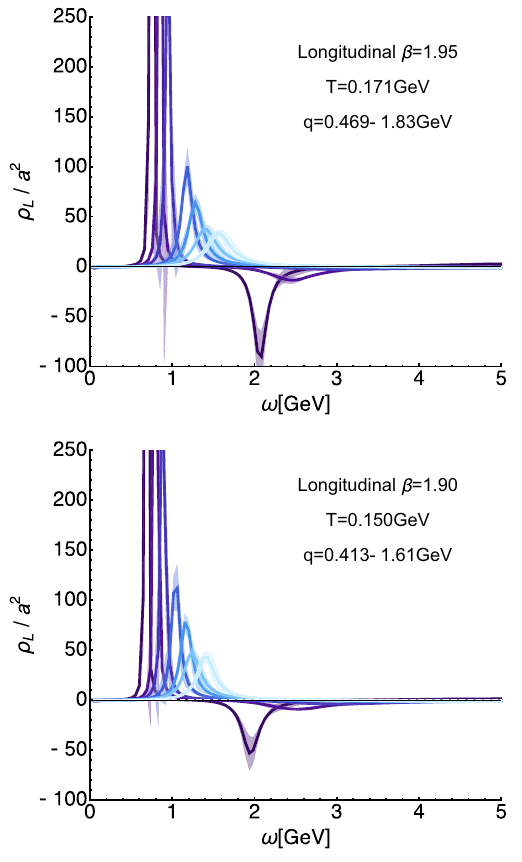
Fig. 8 For completeness we show here the reconstructed longitudinal (left) and transversal (right) gluon spectra on the β = 1 . 95 (top) and β = 1 . 90 (bottom) ensembles at the lowest available temperatures. The